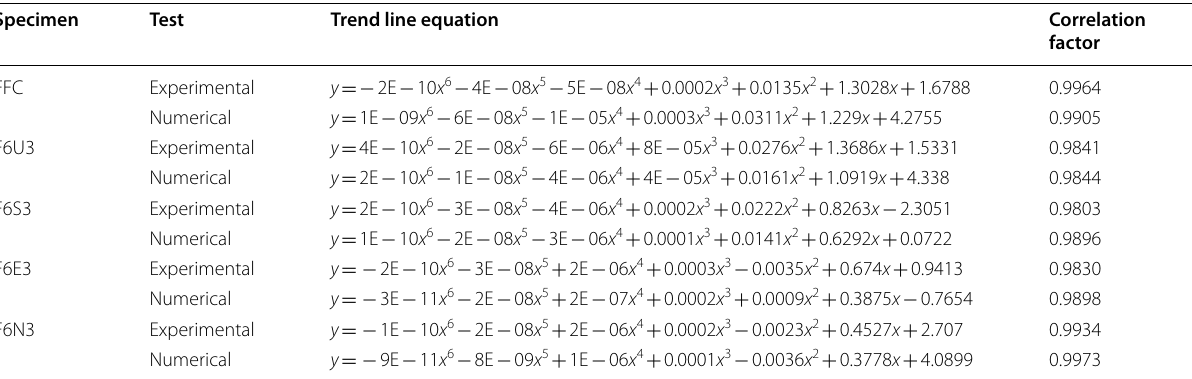
Table 10 Trend line comparison Specimen Test Trend line equation Correlation